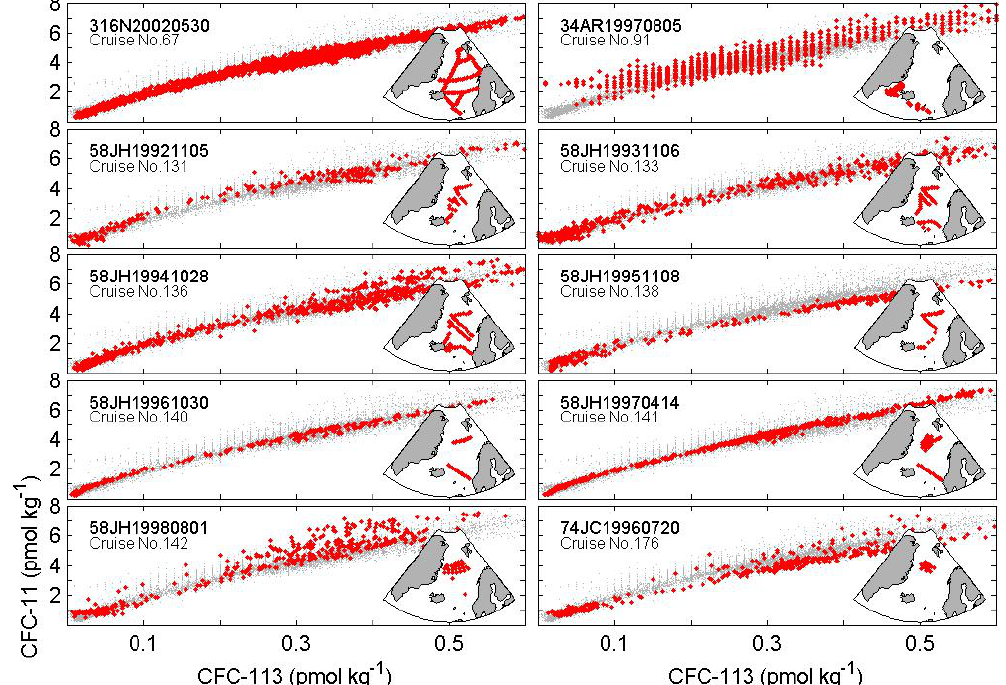
Figure 7. CFC-11 vs. CFC-113. See Fig. 2 for